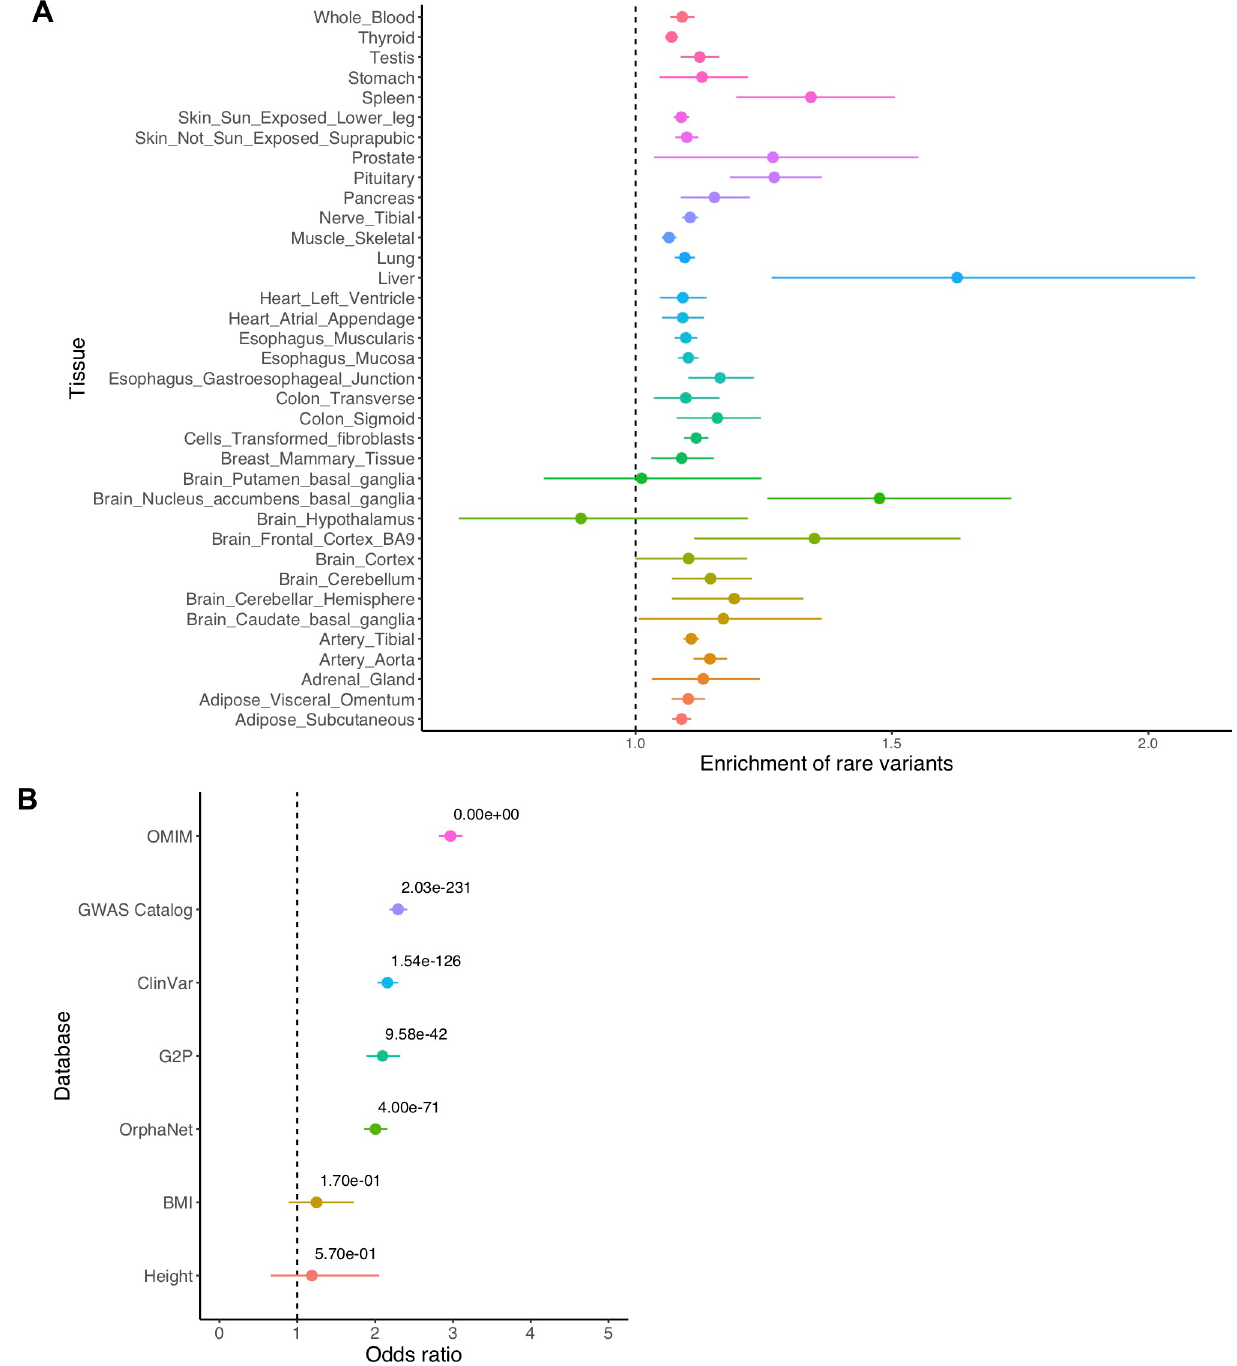
Fig 4. Outlier analysis of RV eGenes detected by LRT-q in GTEx v8. A. Enrichment of proximal rare variants in outliers compared to non-outliers for RV eGenes in each tissue. Tissues without RV eGenes are excluded. B. Enrichment of RV eGenes in disease-associated genes and genes related to common traits (BMI and Height) from public databases. The numbers represent p-values. In both panels, we show the mean values as dots and 95% confidence intervals as error bars.